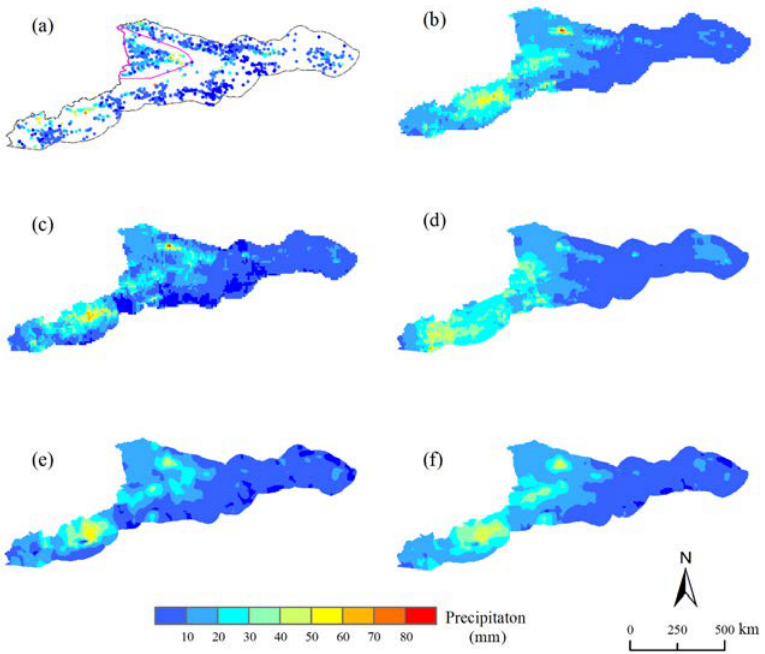
Figure 11. The spatial distributions of the five estimated precipitation datasets and the observed precipitation in September 2017. ( a ) OBS; ( b ) OIMERG; ( c ) CIMERG; ( d ) DS_Spline; ( e ) DS_CIMERG; ( f ) DS_OIMERG) .